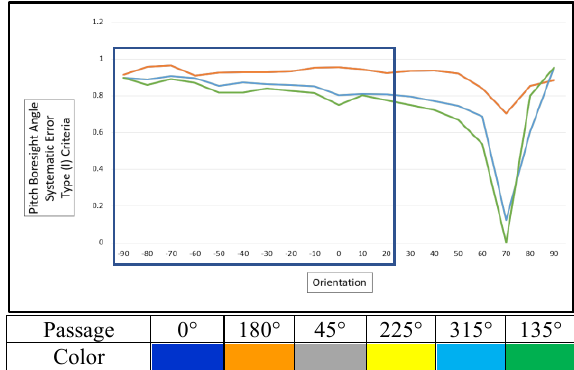
Figure 10 – Pitch boresight angle Type (I) systematic-error visibility criterion (vertical axis in meter) of all the possible orientations (horizontal axis in degree)